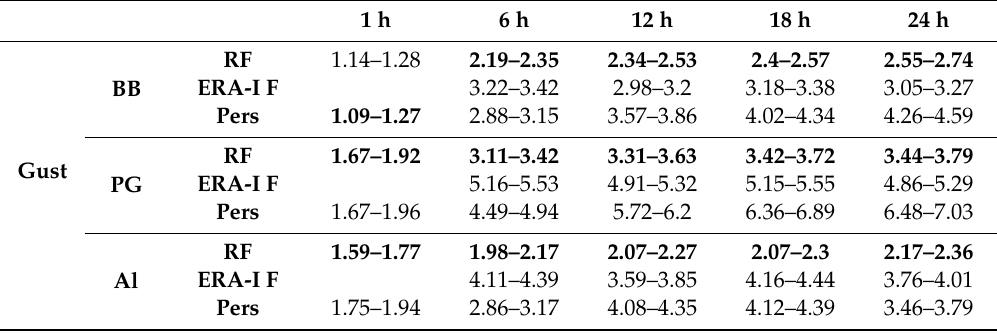
Table 8. RMSE index (95% confidence interval) of wind gust for the steps 1, 6, 12, 18, and 24 h, for three locations (Bilbao Bizkaia, Punta Galea, and Alegria), and RF, ERA-Interim forecasts, and persistence models. Lowest RMSE values are highlighted by using bold